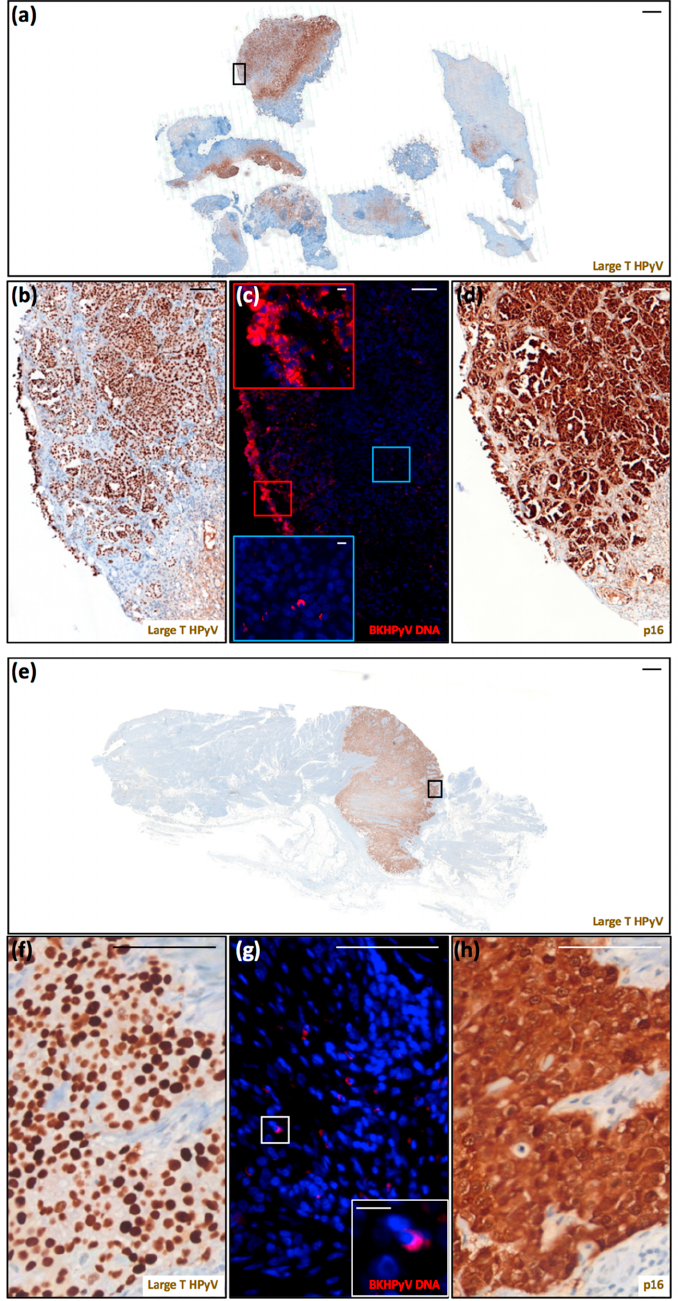
Figure 3. Detection of polyomavirus large-T antigen, BKPyV DNA, and cellular p16 INK4a in two uri- nary bladder carcinomas. ( a ) Scan of a tissue section of the urinary bladder carcinoma from patient 13 labeled for LT (scale bar: 1000 μ m). ( b – d ) These panels correspond to the black square highlighted in ( a ). ( b ) Magnification of LT labeling (scale bar: 100 μ m). ( d ) Scan of a serial section labeled for